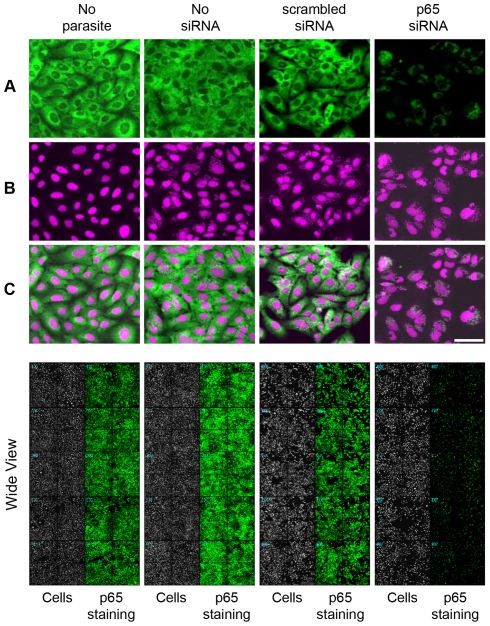
Validation of the secondary screening.The secondary screening was performed in 96-well plates. To validate this format, U2OS cells were seeded, transfected with the appropriate siRNAs and then infected with T. cruzi trypomastigotes as detailed in Materials and Methods. From left to right, cells were immunostained for p65 protein in the absence of T. cruzi parasites, in the absence of siRNAs, in the presence of scrambled siRNA or in the presence of p65 siRNA, respectively. (A) Immunofluorescence staining against p65 protein (green). (B) DNA staining of cell and parasite nuclei (DRAQ5, purple). (C) Overlay images. In the bottom panel, a wide view of the plate wells, showing p65 protein labeling (green) and cells (white). The rightmost column evidences the p65 knockdown when cells were transfected with p65 siRNA. Scale bar represents 80 µm.